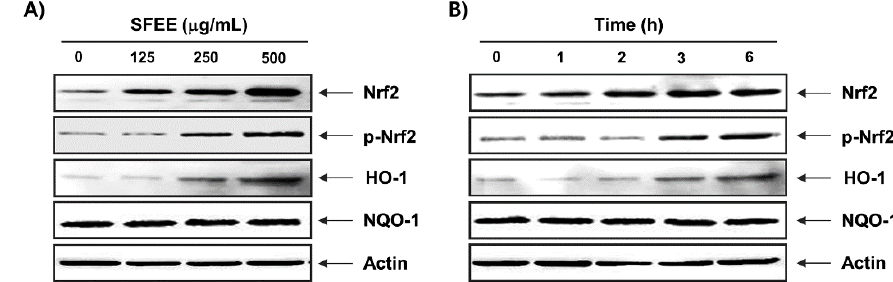
Figure 4. Induction of nuclear factor-erythroid 2 related factor 2 (Nrf2) and heme oxygenase-1 (HO-1) expression by Schisandrae Fructus ethanol extract in C2C12 cells. The cells were incubated with various concentrations of Schisandrae Fructus ethanol extract (SFEE) for 6 h ( A ) or for the indicated periods with 500 μg/mL SFEE ( B ). Cellular proteins were separated on SDS-polyacrylamide gels and transferred to nitrocellulose membranes. The membranes were probed with specific antibodies against Nrf2, p-Nrf2, HO-1, and NAD(P)H quinone oxidoreductase 1 (NQO-1). Actin was used as the loading